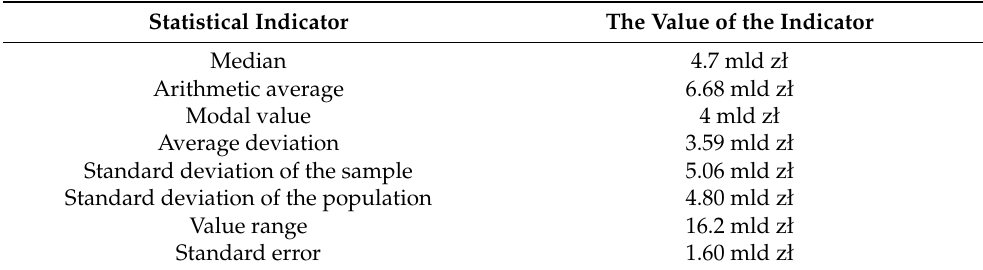
Table 4. Statistical indicators of measures of the largest mergers and acquisitions from 2010–2019. Statistical